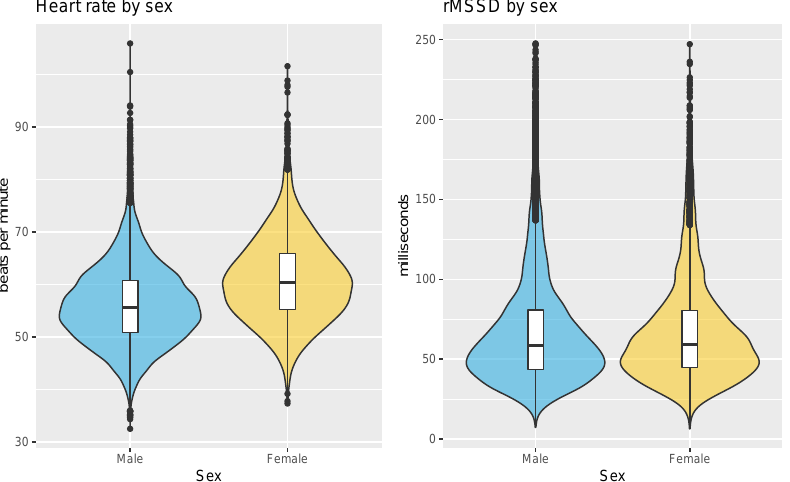
Figure 4. Resting heart rate and HRV by sex. Heart rate is on average 5 bpm higher in female users, while HRV is very similar between male and female users, on average.